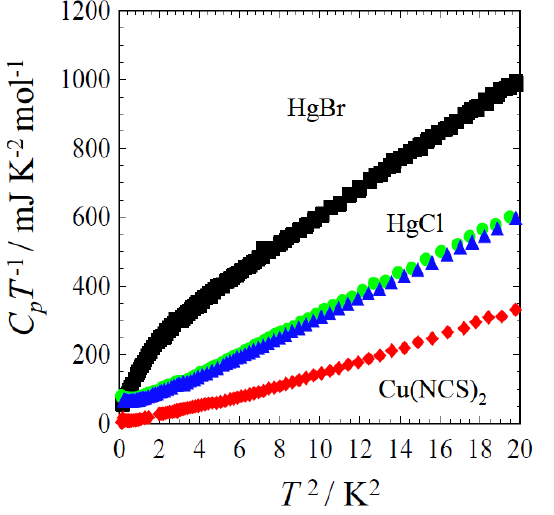
Cu(NCS) (red) are also 2 2